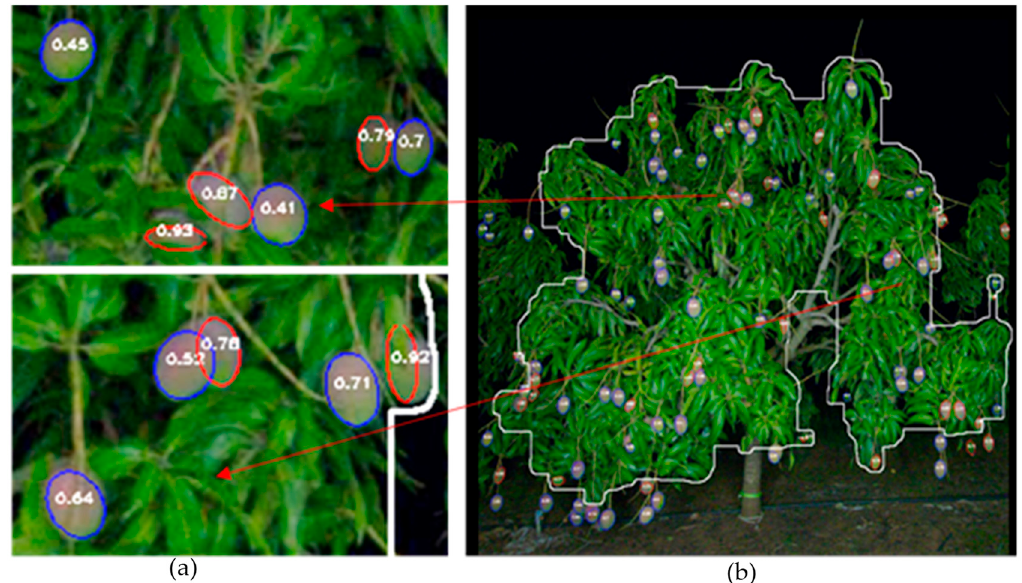
Figure 5. Ellipse fitting and canopy extraction. ( a ) Fruit enclosed by blue ellipse contour and red ellipse contour represent the fully exposed fruit and partly occluded fruit, respectively. ( b ) Area enclosed by the white contour around the tree represents the segmented canopy foliage area. Eccentricity values are displayed.